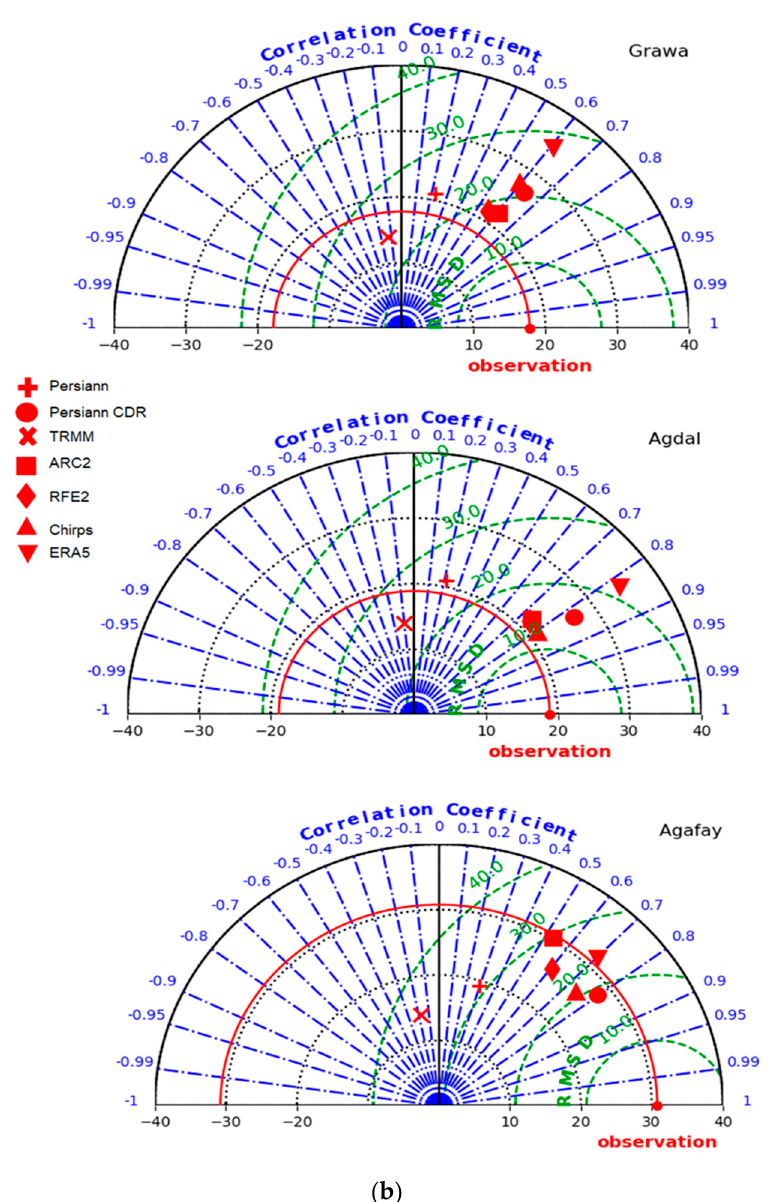
Figure 7. ( a ) Taylor diagram of monthly precipitation at Tachedert, Imskerbour, and Asni weather stations; ( b ) Taylor diagram of monthly precipitation at Grawa, Agdal, and Agafay weather stations. Imskerbour (1404 mm)